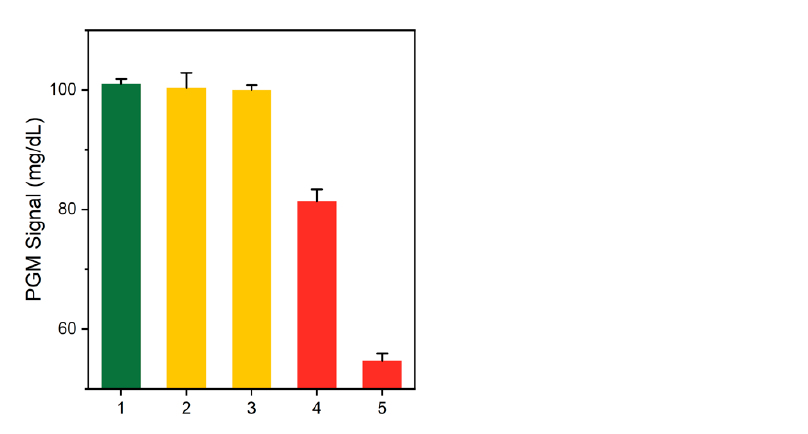
Figure 3. Detection feasibility of the PGM-based IgE assay. The PGM signals from different samples containing (1) no enzyme with target IgE, (2) only hexokinase with target IgE, (3) only hexokinase without target IgE, (4) both hexokinase and pyruvate kinase with target IgE, and (5) both hexokinase and pyruvate kinase without target IgE. The concentrations of target IgE, hexokinase, and pyruvate kinase were 1 μ g/mL, 50 unit/mL, and 50 unit/mL, respectively.